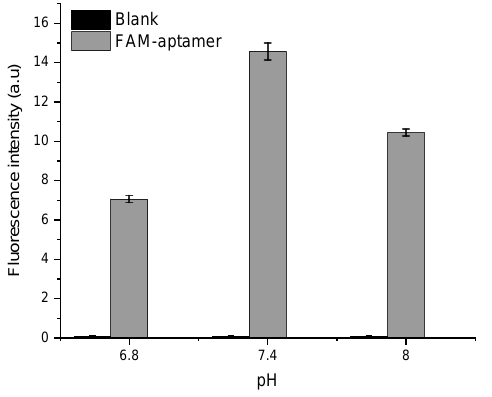
Figure 6. pH optimization based on the FAM-APT fluorescence intensity at 0.25 µM.